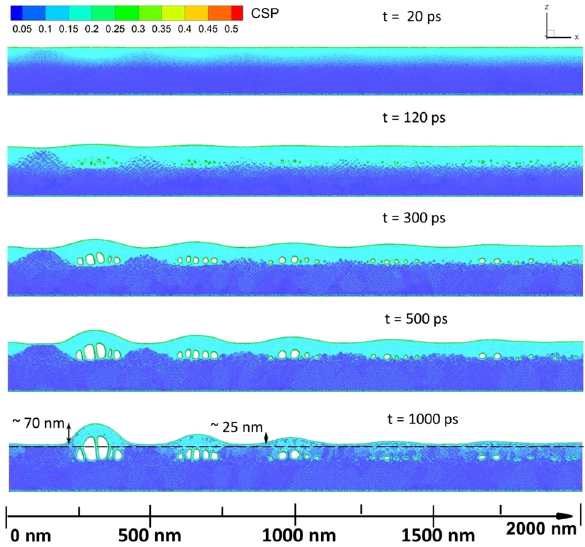
Figure 4: MD-TTM simulations of LIPSS. Atomic snapshots of the Au target for the case of an incident fluence of 130 mJ/cm 2 are depicted for the times of 20 ps, 120 ps, 300 ps, 500 ps and 1000 ps after the pulse. The atoms are colored by the Central Symmetry Parameter (CSP)fordistinguishing thelocalcrystalstructureasfollows:crystal <0.08 < defects (dislocations) < 0.11 < liquid < 0.25 < surfaces < 0.50 < vapor (free atoms). The CSP parameter is shown in the fi gure as a color scale bar. The dashed line at the last snapshot indicates the sample surface before the